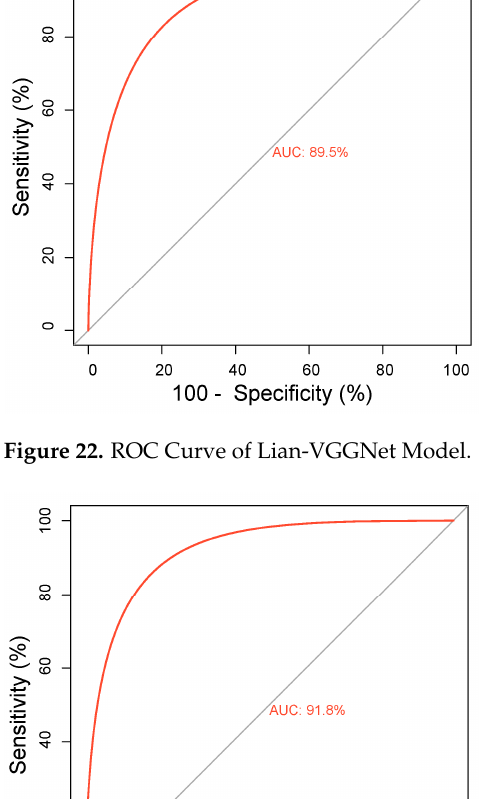
Figure 21. ROC Curve of VGGNet Model.